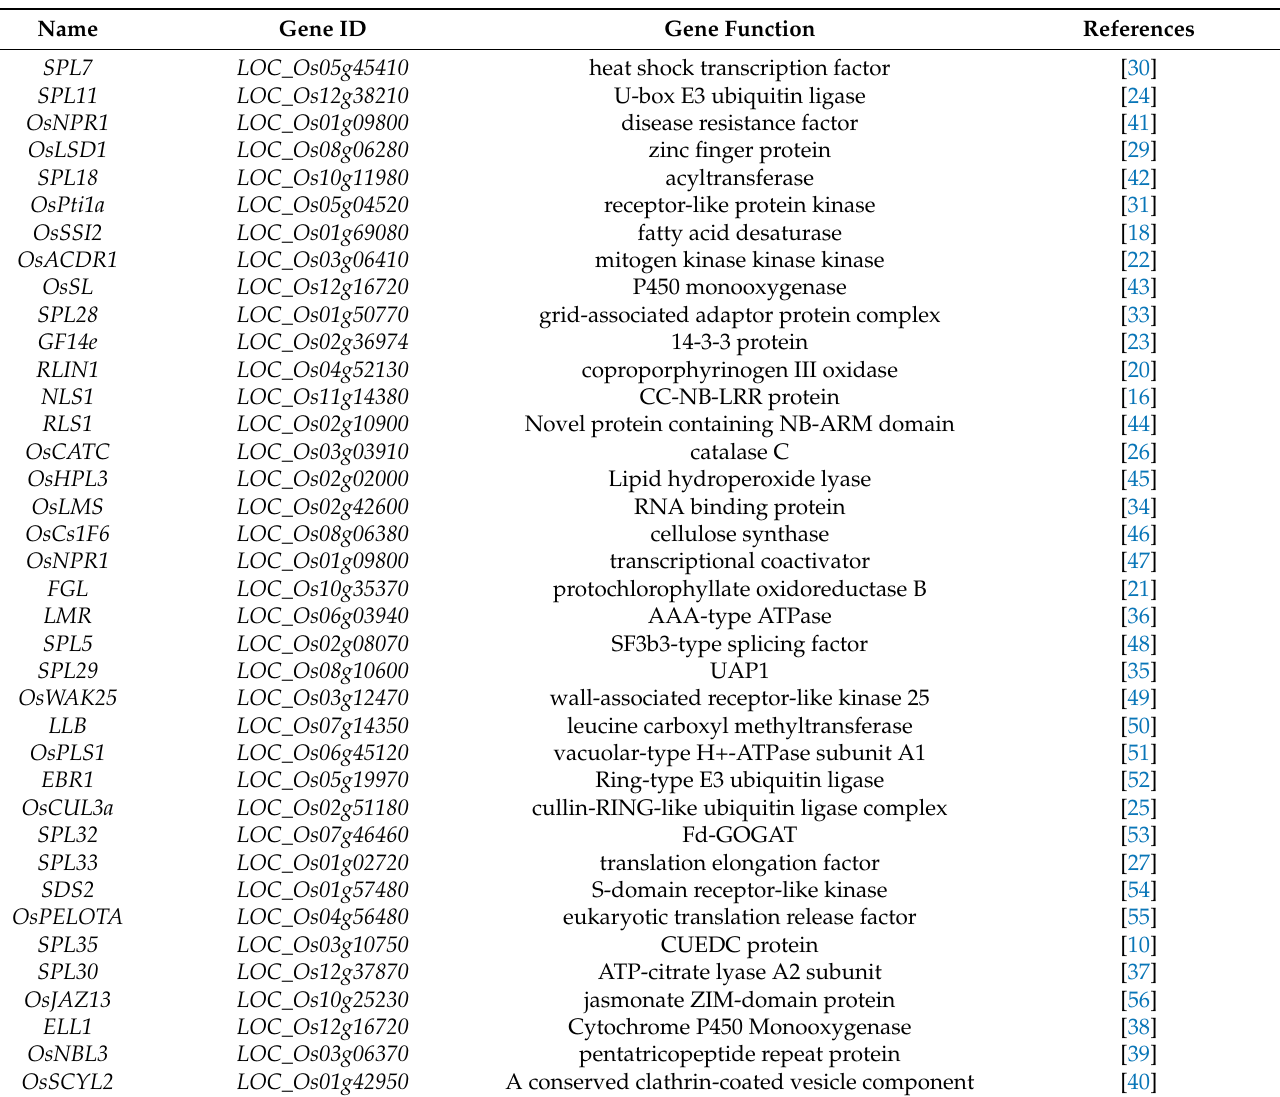
Table 1. Partial of the cloned genes of rice lesion mimic